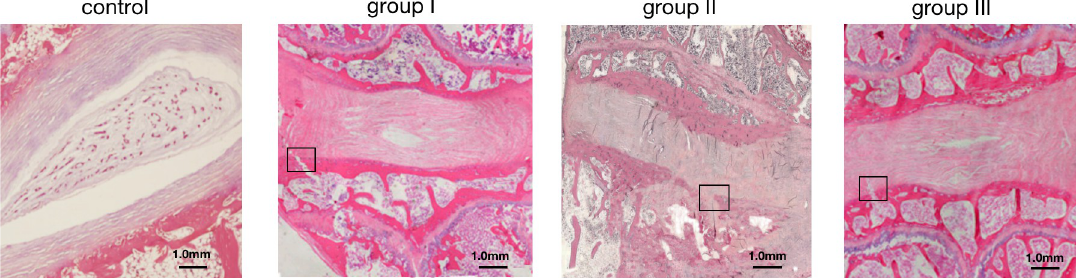
Fig 2. Typical histological images of slices from the three groups of rabbits at eighth weeks after the inoculation. The intervertebral discs from the TSB-inoculated control segment (L4-L5) had distinct nucleus pulposus and normal arranged annulus fibrosus. The segment of three types of C . acnes inoculated intervertebral discs (L5-L6) was demonstrated as disappearance of nucleus pulposus, endplates fracture (black rectangle), disorganized annulus fibrosus, and partly cartilage